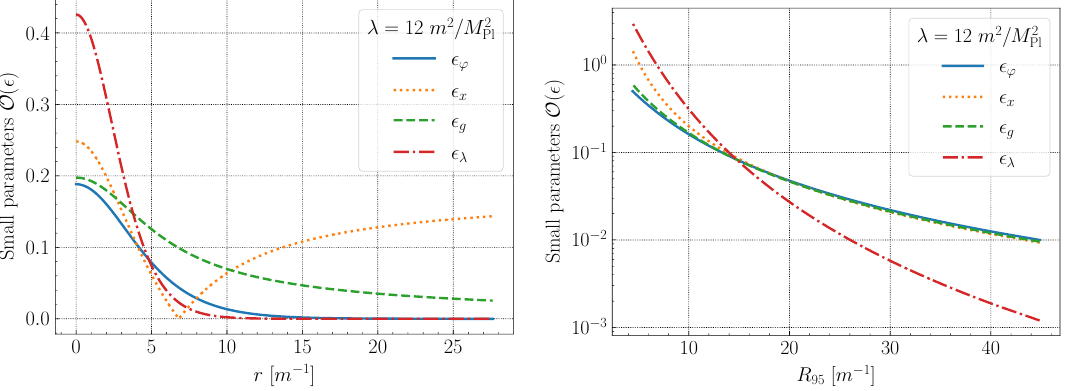
/m 2 | (as would be the case for QCD Pl /m 2 | increases. Pl